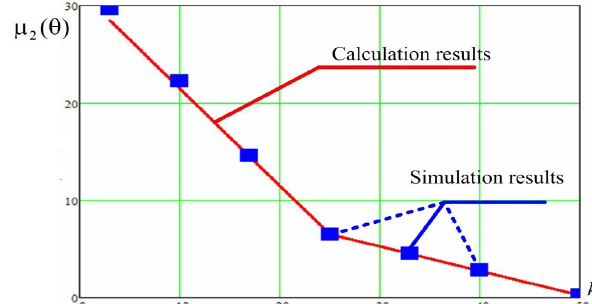
Figure 3. Dependence of the variance of decisive statistics θ on parameter k according to the data of Table